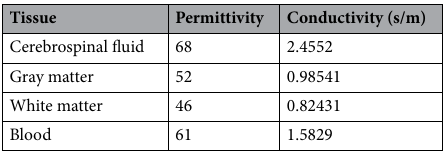
Table 1. Permittivity and conductivity of brain tissue at 1.2 GHz.